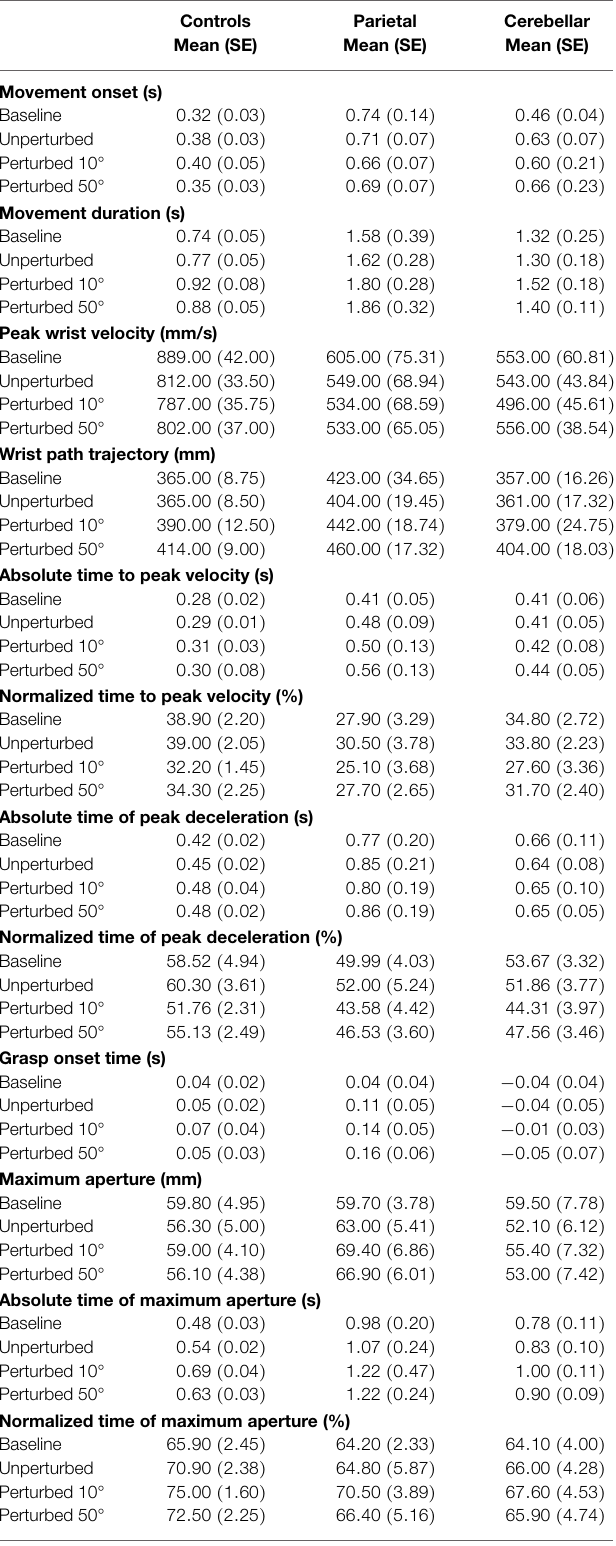
TABLE 2 | Means and standard errors (SE) for kinematic parameters in each group and each condition .